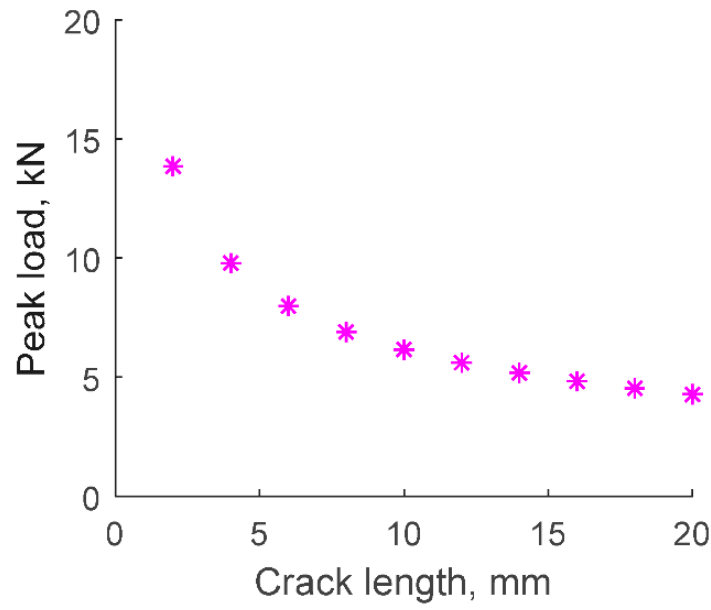
Figure 10. Load prediction for the constant-SIF crack growth experiment.